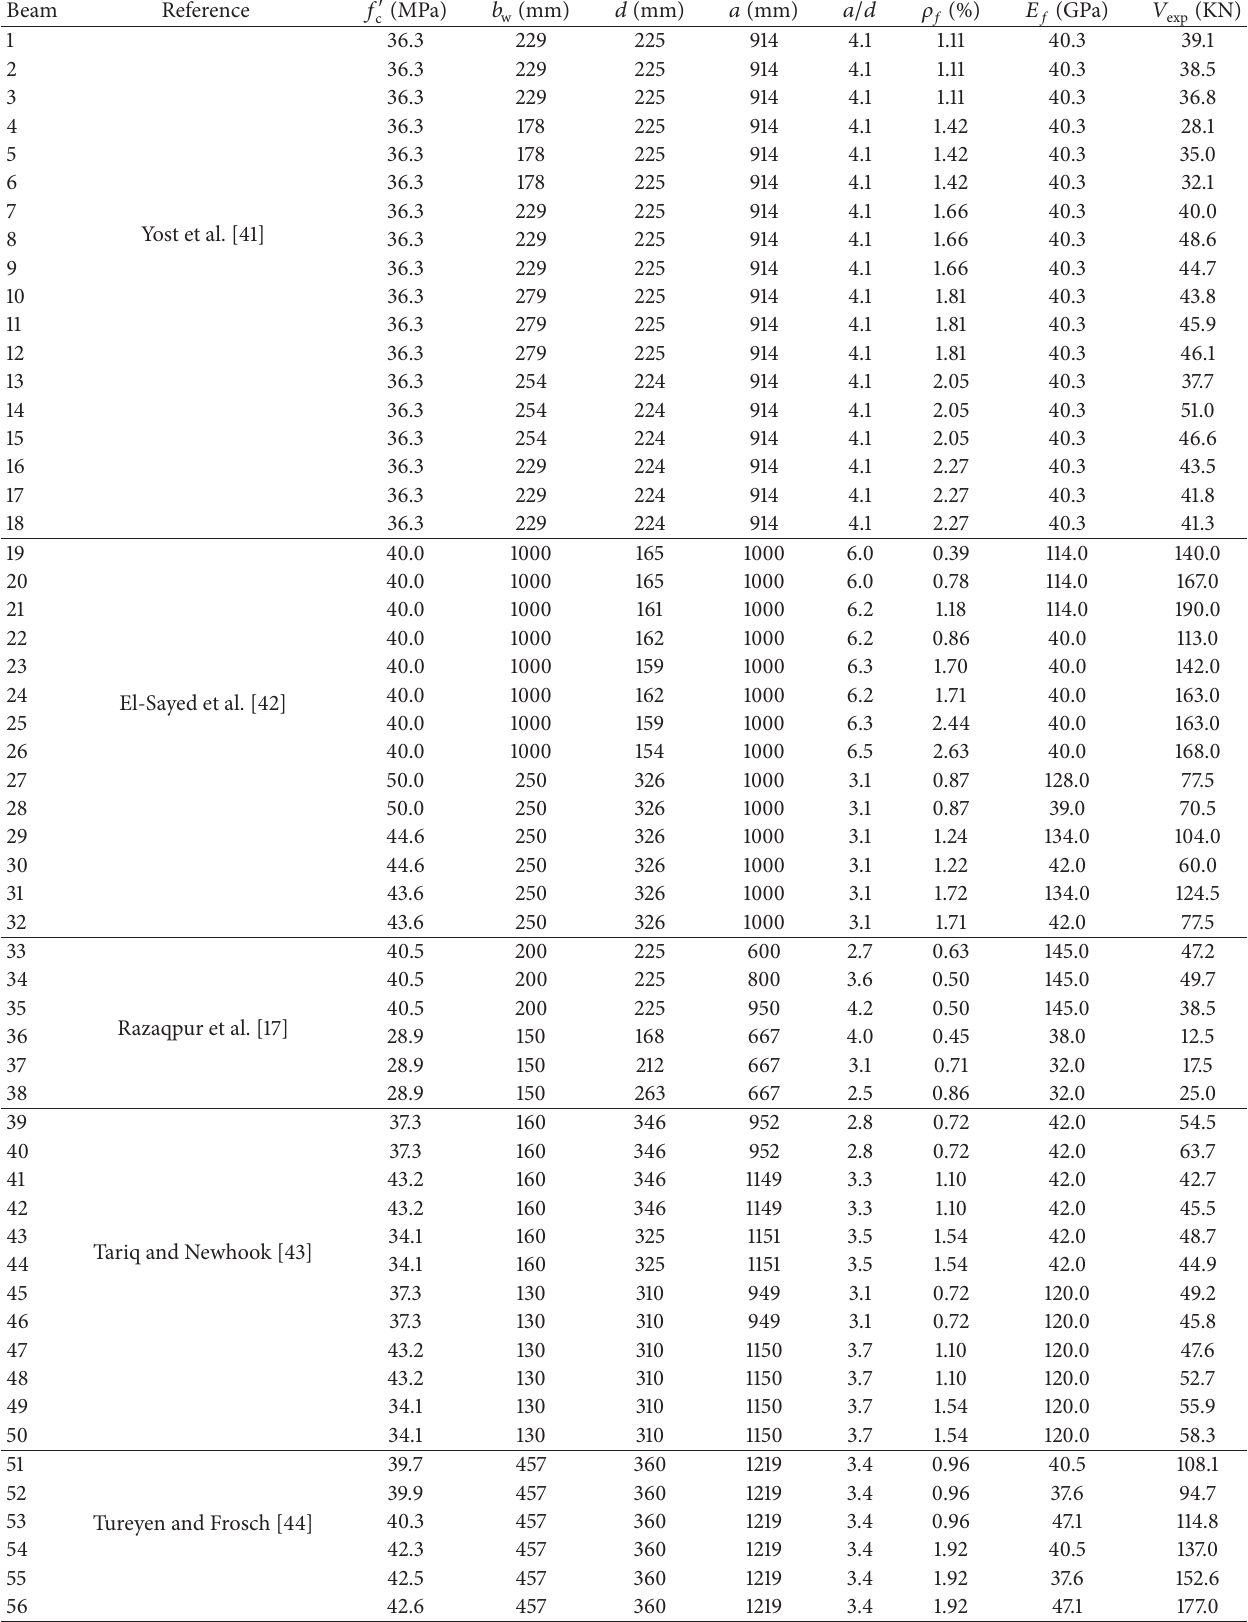
Table 6: Database of experimental results of FRP reinforced concrete